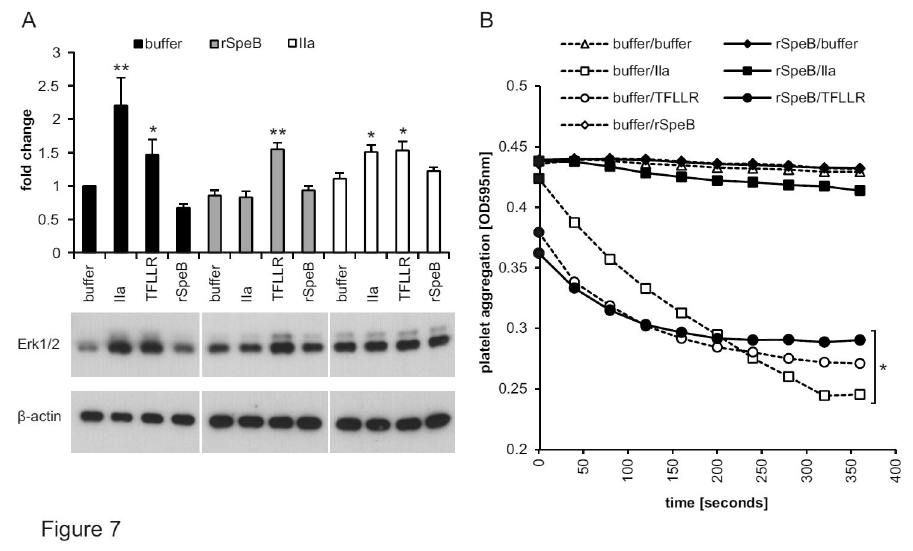
Figure 7. SpeB-cleaved PAR-1 silenced ERK1/2 phosphorylation and blunted thrombin-mediated platelet aggregation. ( A ) Following pre-incubation with buffer alone (open bars), commercial SpeB (grey) or thrombin (black) EA.hy926 endothelial cells were treated with given agonists and assessed by Western blot. β-actin served as loading control. The upper part of the panel provides quantitative analysis of 4 pooled experiments; one-way-ANOVA yielded P <0.001 overall, P <0.004 for buffer, P <0.001 for speB and P <0.021 for IIa pre-incubated subgroups. Within each subgroup samples were compared to the corresponding buffer control (Dunnet’s posthoc comparison) * P <0.05, ** P <0.01. The lower part of the panel shows a representative blot with visualized bands for phosphorylated ERK and β-actin. ( B ) Washed human platelets were pre-incubated 15 min with buffer alone (open symbols) or commercial SpeB (closed symbols) before addition of indicated agonists and quantification of aggregation. Representative graph of 3 experiments with N=9, data presented as mean+/- SEM, * P <0.05, ** P